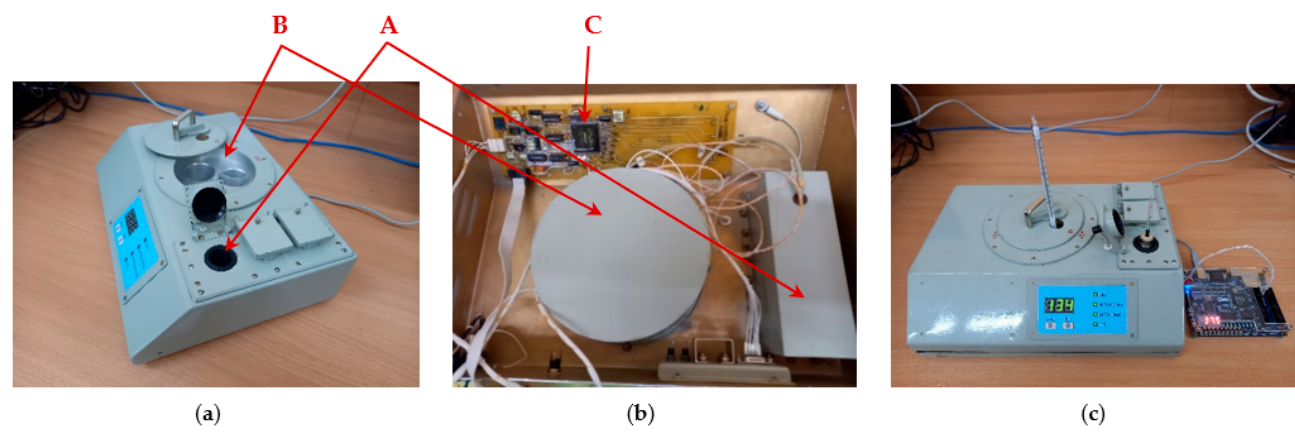
Figure 7. The cholinesterase activity analyzer: ( a ) exterior view of analyzer; ( b ) sensor installation; ( c ) temperature control using the proposed implementation and using mercury thermometers.